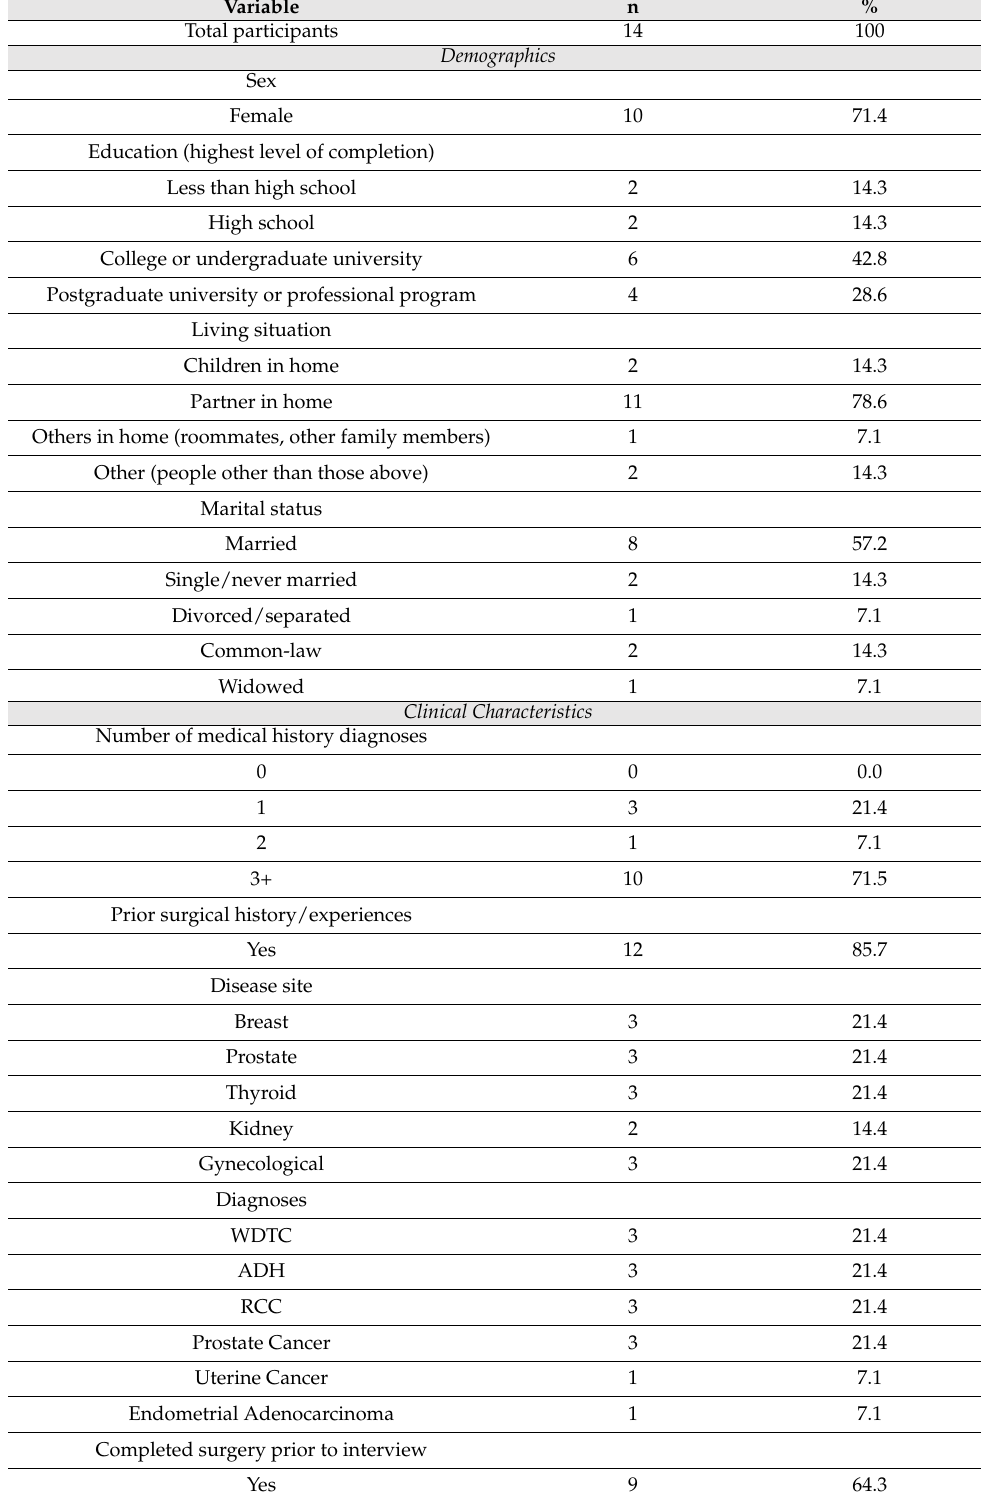
Table 1. Participant